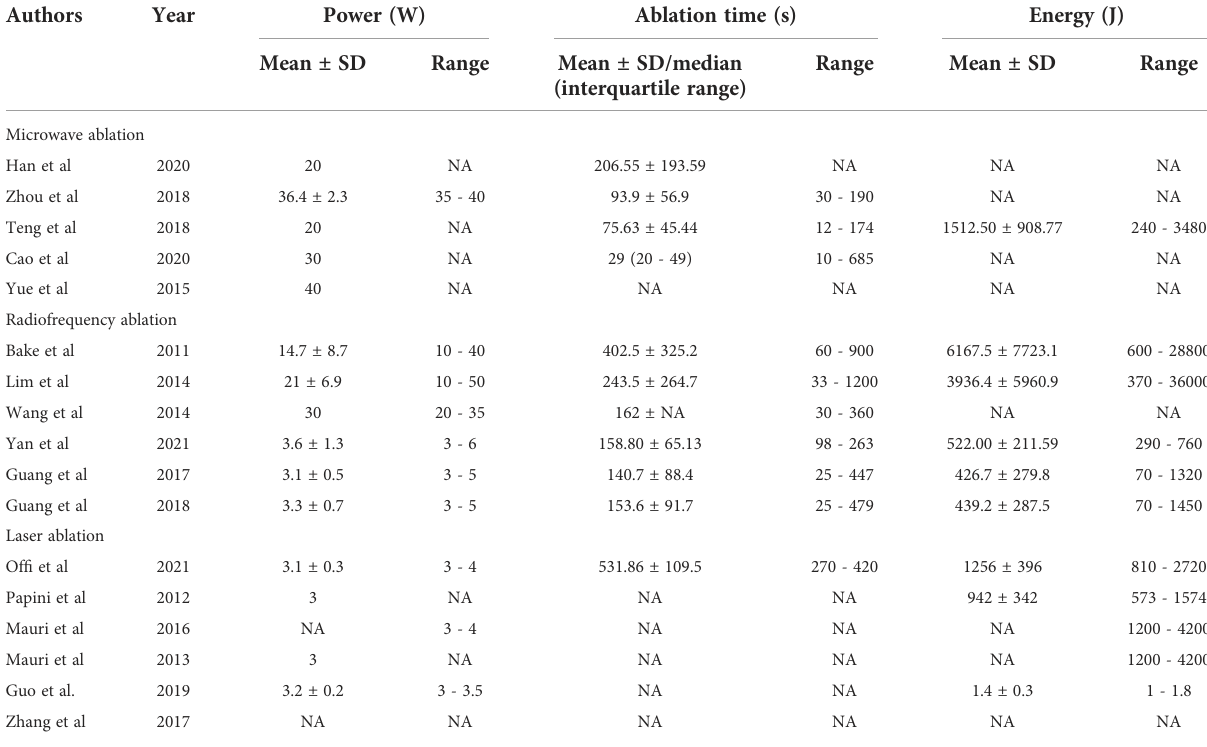
TABLE 2 Details of ablation